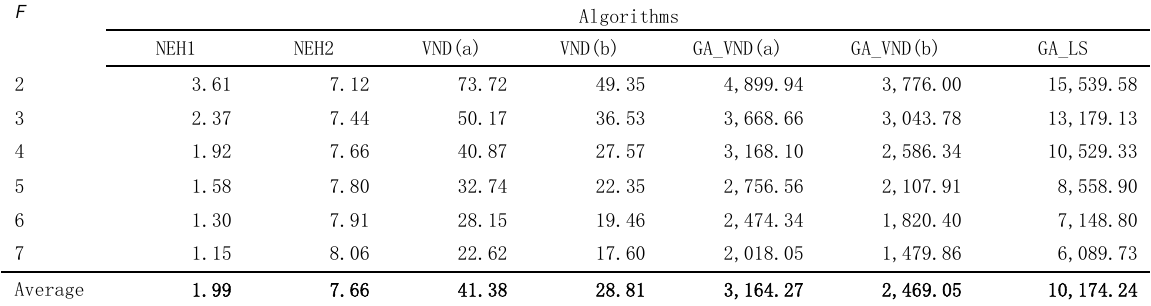
Fig. 5. Tukey HSD intervals at 99% confidence level for the algorithm factor Table 4. Average CPU times of algorithms grouped by F